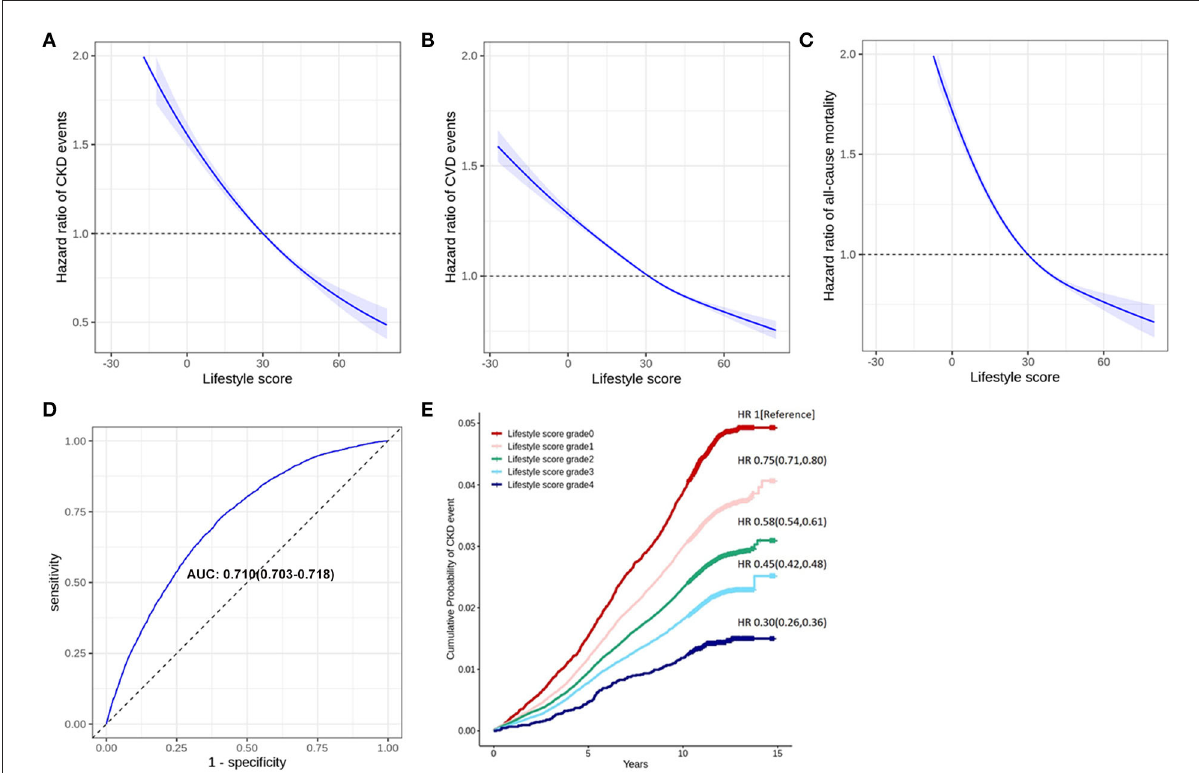
FIGURE2 Validation of the lifestyle score in long-term outcomes. Panel (A) shows a restricted cubic spline regression analysis, which indicates a linear relationship between the total lifestyle score (equals to the scores of healthy lifestyle factors minus the scores of unhealthy lifestyle factors) and risk of CKD events. Panel (B) shows the categorization for risk of CKD event according to the total lifestyle score. Panel (C) shows the receiver operator characteristic curves (ROC) of the age-adjusted lifestyle score. Panel (D) or (E) is a restricted cubic spline regression analysis, which indicates a linear relationship between the total lifestyle score (equals to the scores of healthy lifestyle factors minus the scores of unhealthy lifestyle factors) and the risk of CVD events or all-cause